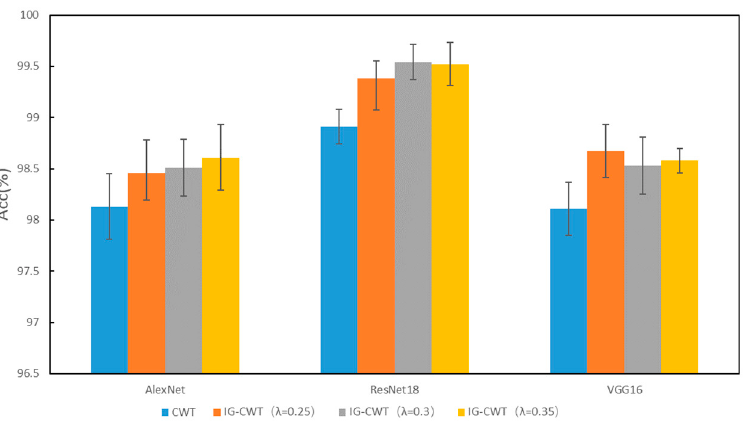
Figure 3. PU accuracy of IG ‐ CWT and CWT.